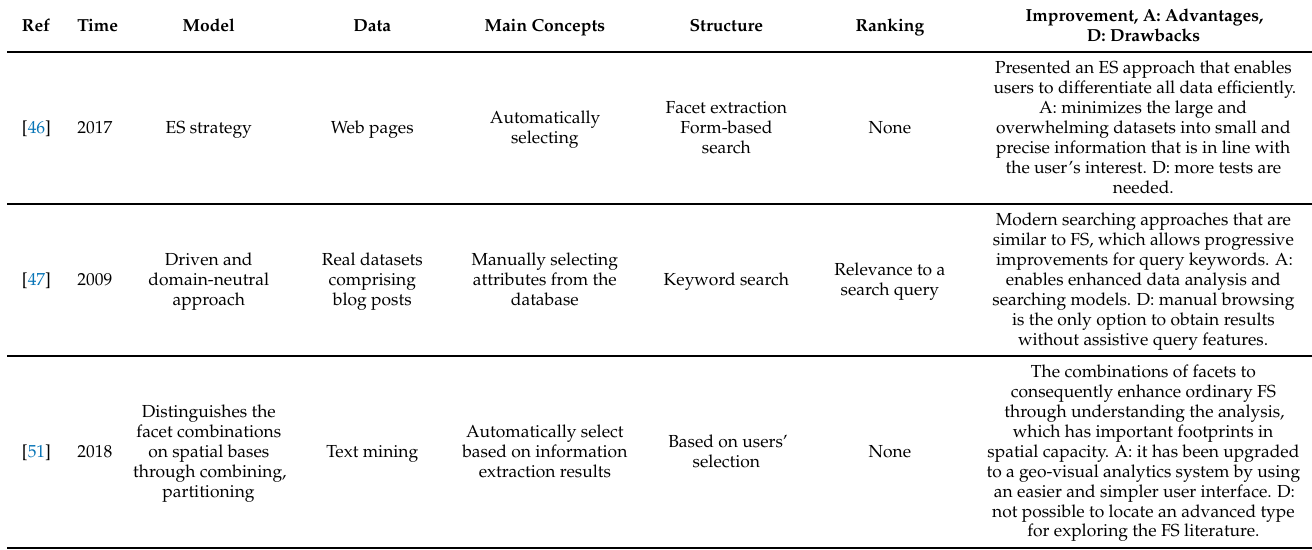
Table 2. Comparison of existing facet